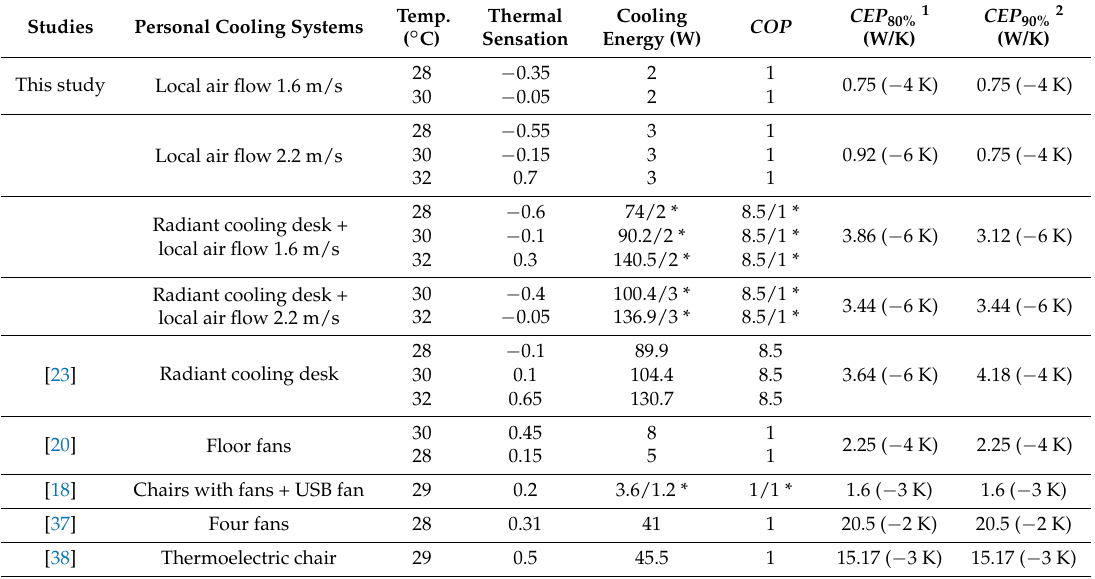
Table 11. Basic information of personal cooling systems in this study and previous ones.